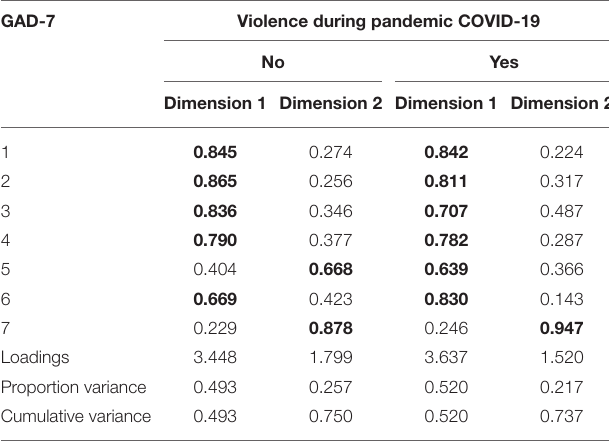
TABLE 3 | Principal component analysis of each item in GAD-7 of the population